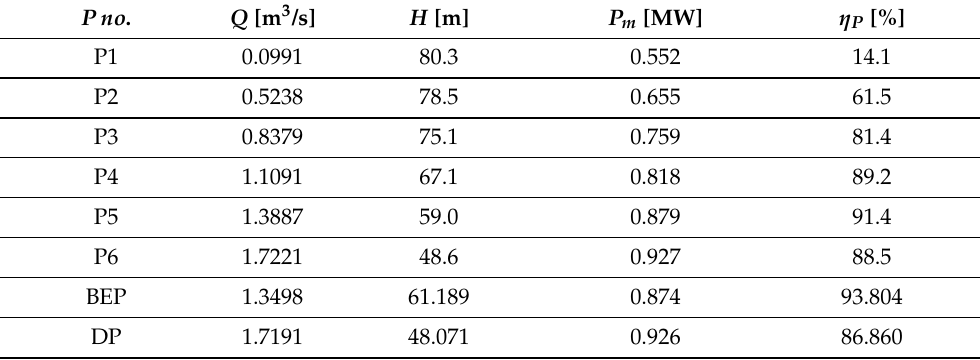
Figure 17. The experimental data provided by the manufacturer ( (cid:4) , functions H ( Q ) , P m ( Q ) and η P ( Q ) determined for Worthington 500 LNN-775A double suction pump at speed of 993 rpm. Table 6. The data for Worthington 500 LNN-775A double suction pump at speed of 993 rpm. P no